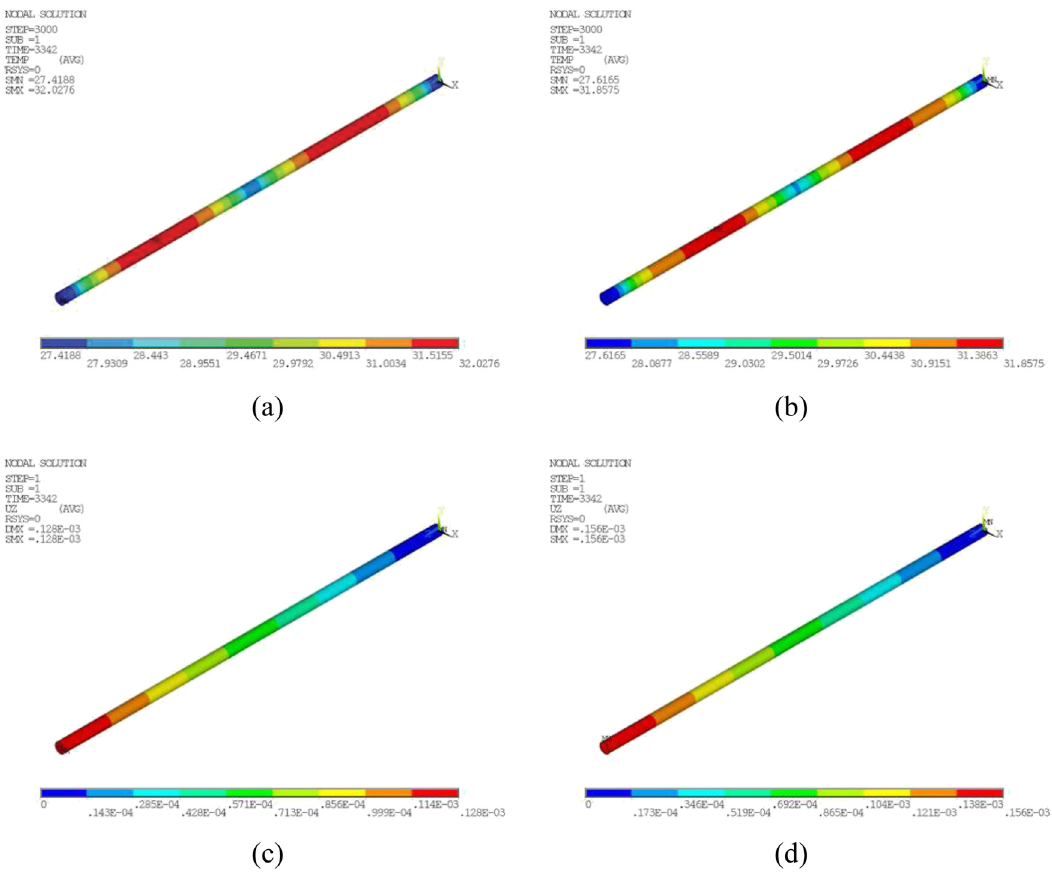
Figure 6: Simulation results of two types of ball screw at 1,400 rpm; temperature distribution of the bio - inspired ( a ) , and standard ball screw ( b ) ; thermal deformation of the bio - inspired ( c ) , and standard ball screw ( d )